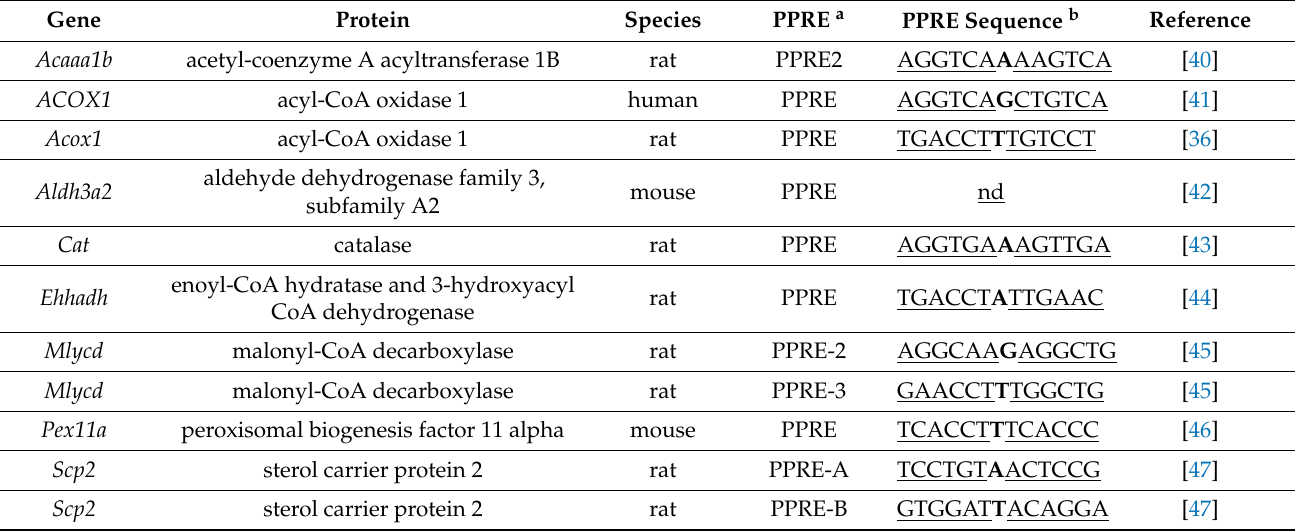
a corresponds, for each gene, to the PPRE numbering as stated in the corresponding reference. b PPREs sequence: PPAR α DR-1 sequences are shown with hexads underlined and spacing nucleotides in